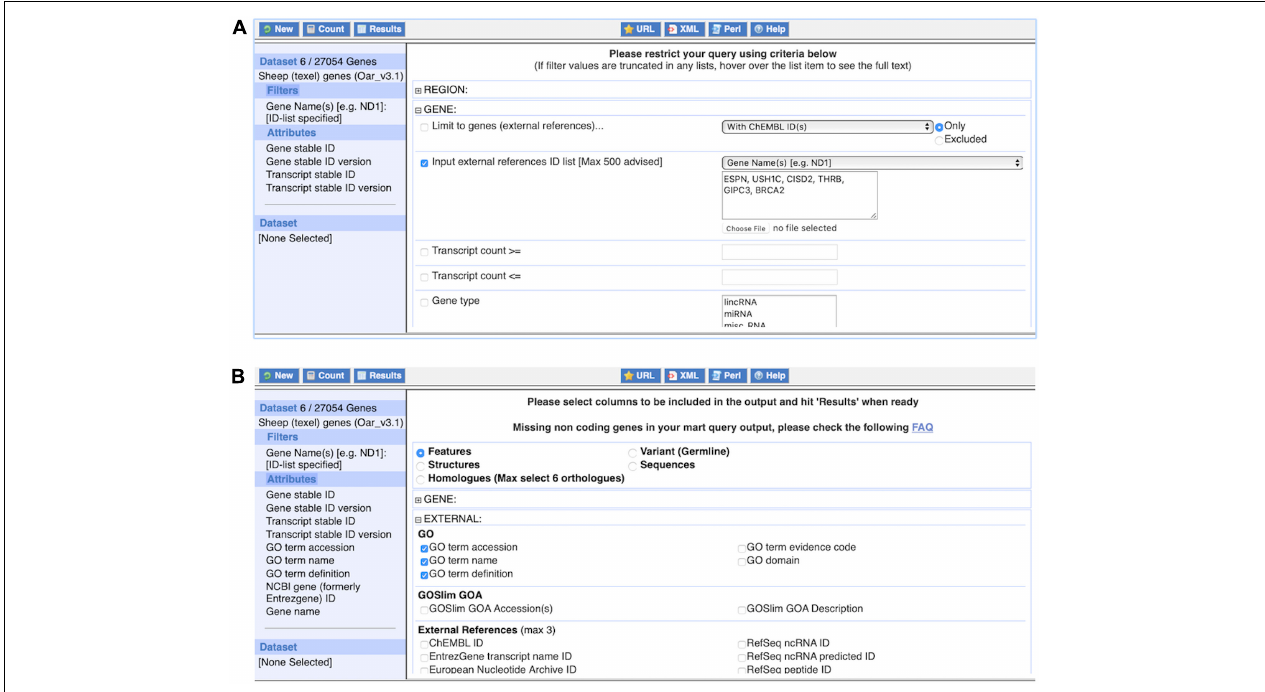
FIGURE 9 | The BioMart web interface. Panel (A) shows the application of one commonly used filter, an external references identifier list, here consisting of six gene names. The dataset size of six genes is displayed after clicking on “Count” at the top left. Panel (B) shows the selection of attributes, here “GO term accession,” “GO term name,” and “GO term definition.” The complete list of attributes, i.e., what will be included in the results table, is shown on the